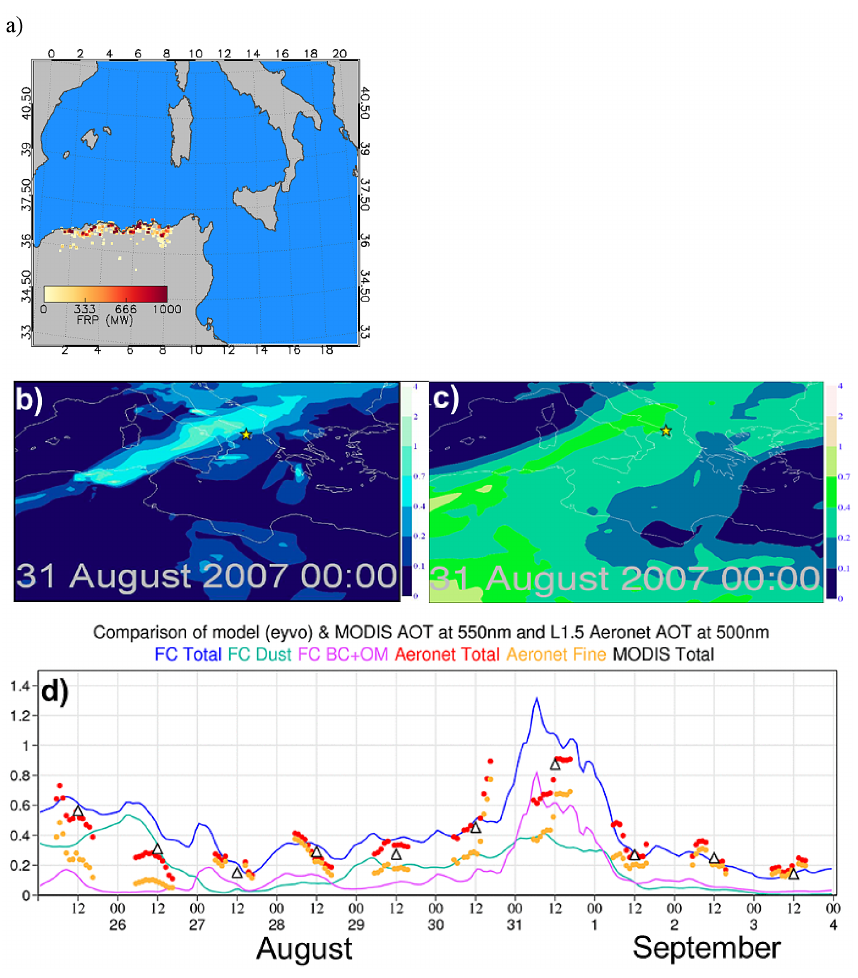
Figure 13. MODIS FRP from the Algerian wildfires (a) between 26 August and 4 September 2007, (b) modelled smoke and (c) modelled dust AOD at 550nm on 31 August 2007 (00:00UTC). (d) time series of daily averaged MODIS total AOD observations (open black triangles), the AERONET observations of total (red circles) and fine-mode AOD (orange circles), modelled total AOD (blue line) and its contributions due to smoke (purple line) and dust (green line). Data sources: MODIS (http://disc1.sci.gsfc.nasa.gov) and AERONET (http://aeronet.gsfc.nasa.gov).